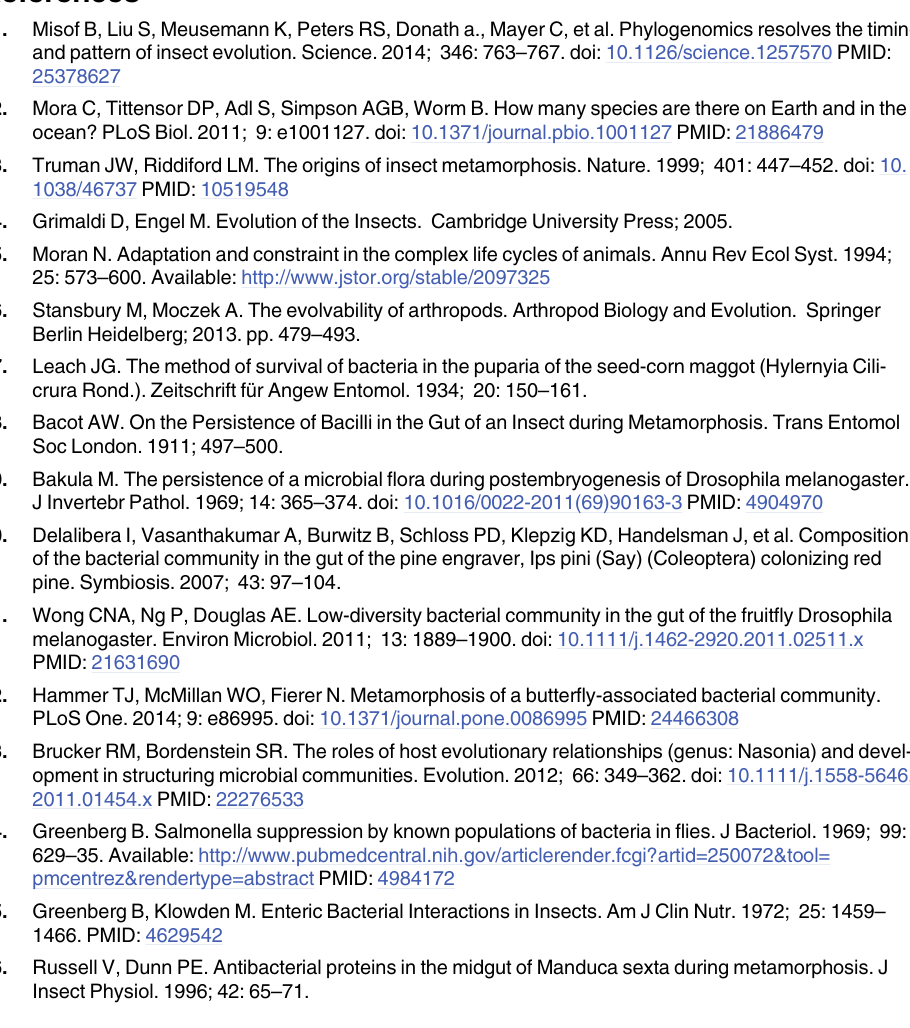
S1 Table. OTU table. S2 Table. Summary of accelerated failure time model for survival data shown in Fig